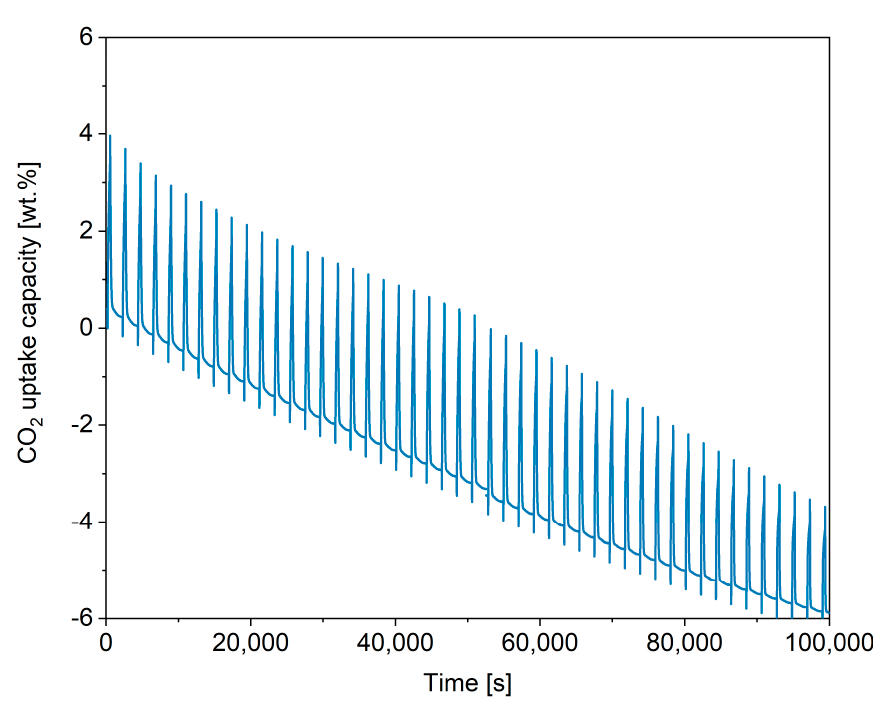
Figure A1. Cyclic stability of K-C after 40 cycles.